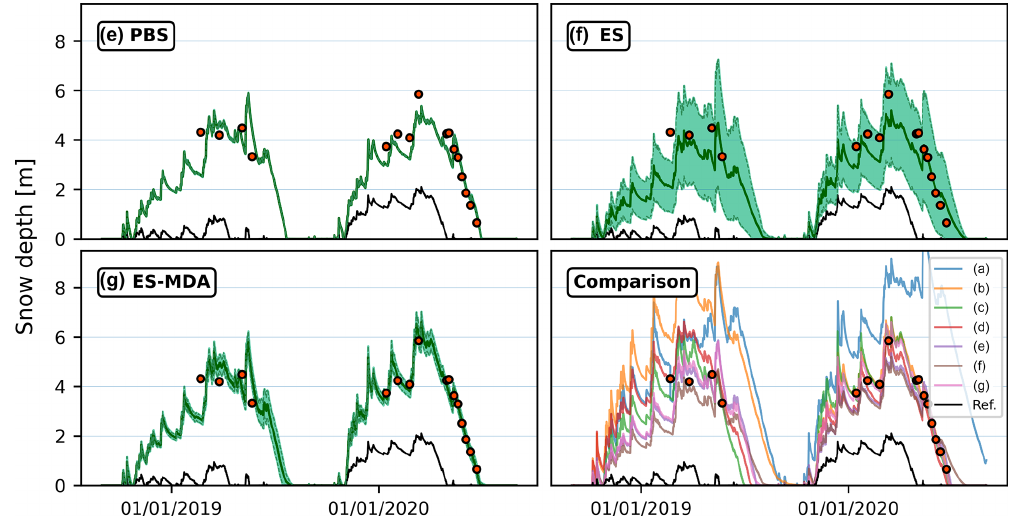
Figure 4. Intercomparison of smoother-based data assimilation experiments and intercomparison of the posterior mean of all the data assim- ilation algorithms (letters a–g correspond to the panels in which the individual schemes are shown in Figs. 3 and 4) in the single cell of the Izas catchment highlighted in Fig. 2. The black line is a deterministic (no perturbations) open-loop simulation for reference, and the red dots are the observations; the dark green line (shading) shows the posterior mean ( ± 1 standard deviation).